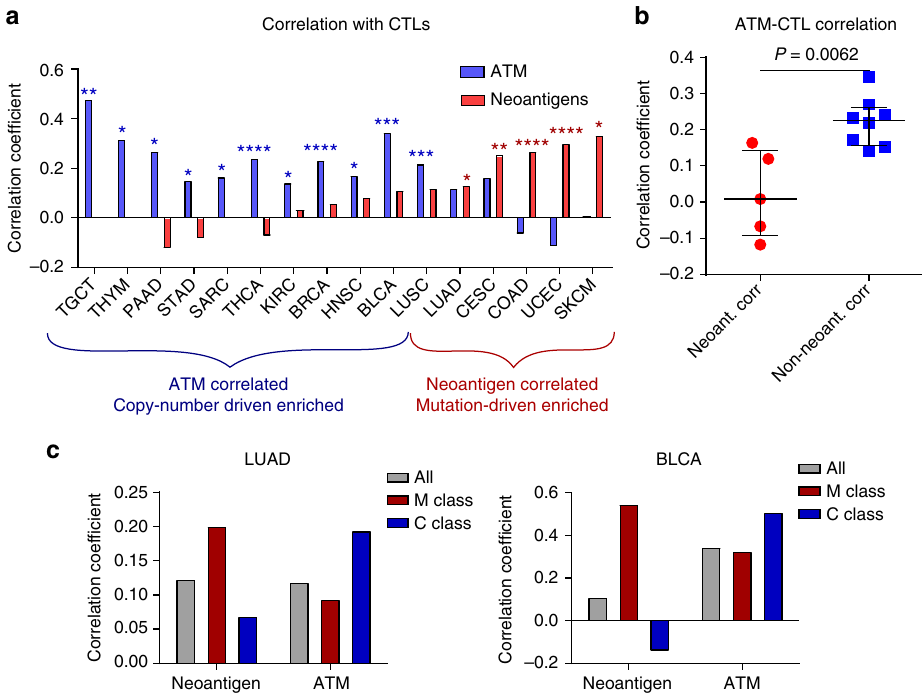
Fig. 8 Neoantigen-independent CTL in fi ltration correlates with increased ATM across cancer lineages. a Spearman correlation coef fi cient between CTL score and total ATM determined by RPPA (blue bars), as well as between CTL score and neoantigen levels (red bars). Individual plots shown in Supplementary Fig. 8A. P -values determined from Spearman correlation coef fi cient and adjusted by Holm-Sidak method. * P < 0.05, ** P < 0.01, *** P < 0.001, **** P < 1 × 10 -4 . b Correlation coef fi cient of total ATM protein and CTL levels. Cancers that had signi fi cant positive correlation with